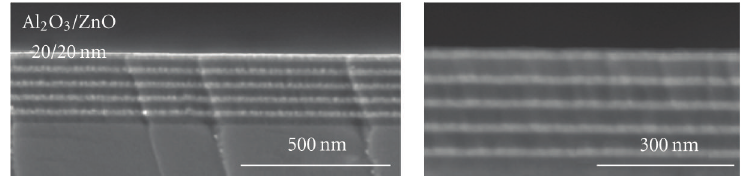
Figure 16: SEM image of the nominal 20nm/20 nm zinc oxide/aluminium oxide multilayer sample for which SIMS results are shown in Figure 15. The bright stripes are the zinc oxide layers, the dark stripes are the aluminium oxide layers, and the substrate is silicon. It can be seen that the zinc oxide layers are thinner than the aluminium oxide layers.